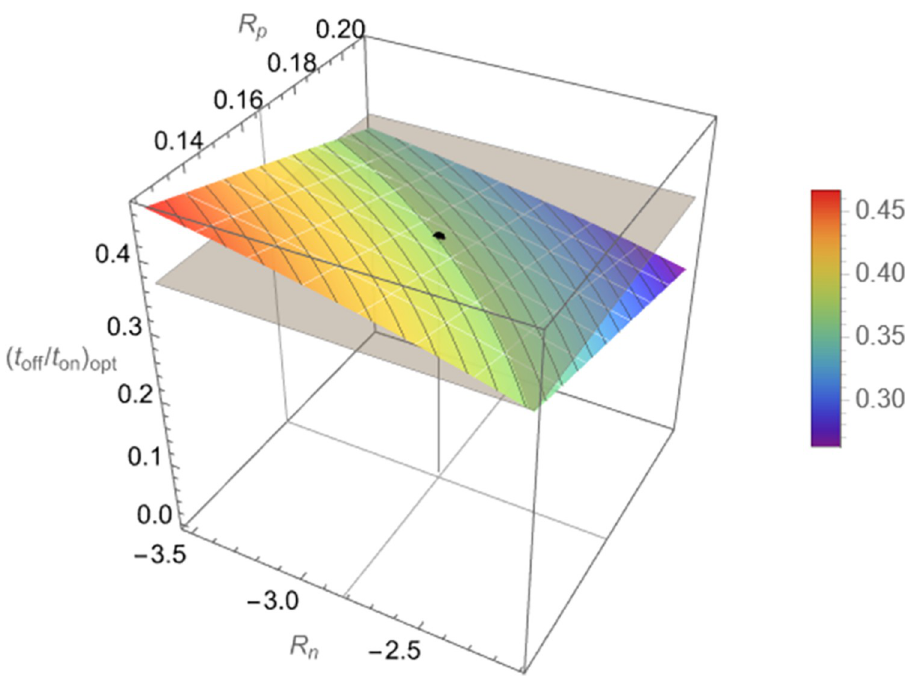
Fig 3. Optimal values ( t on / t off ) opt of the ratio t on / t off that yield maximum decline rate, k , of successive peaks of bacterial population counts, c ( t 2 ℓ ), as a function of the quantities R R n , R p are considered in the range ± 25% of the experimentally estimated values, which correspond to ( t on / t off ) opt � 0.4, marked by the black dot and gray horizontal plane through it.